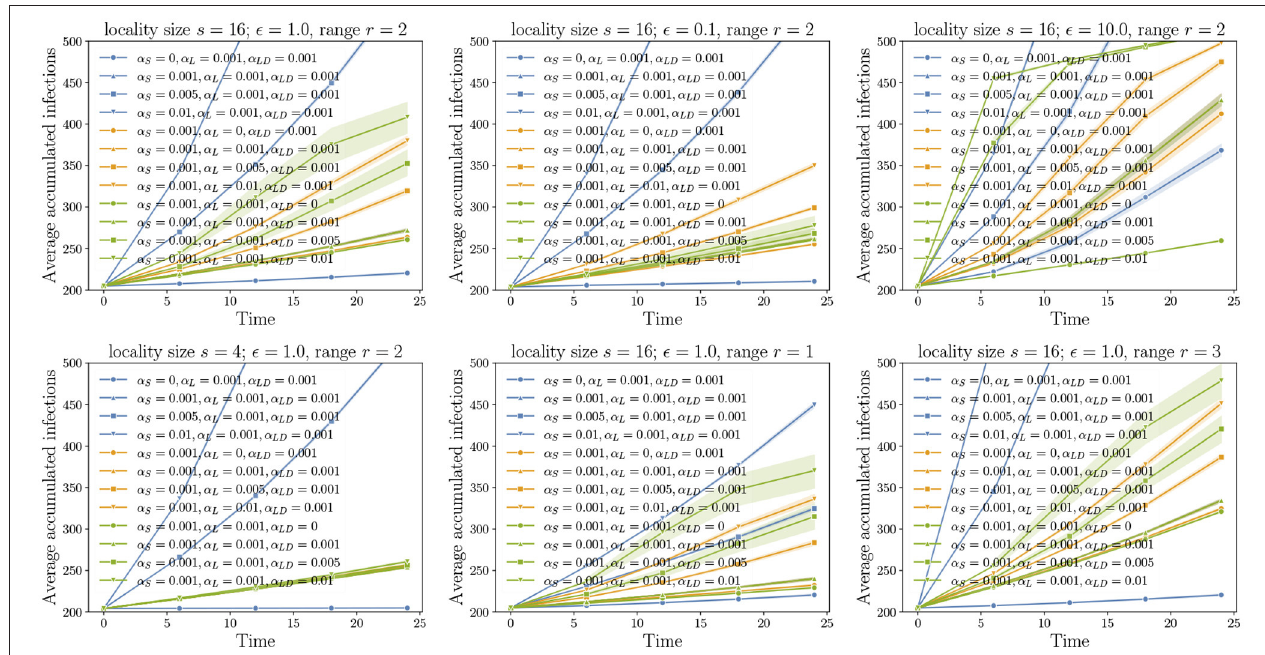
FIGURE 6 | Non-uniform pathway probabilities: In each figure, there are three sets of plots. In each set, two pathway parameters are fixed while the remaining pathway parameter value is varied from 0 to 0.01.